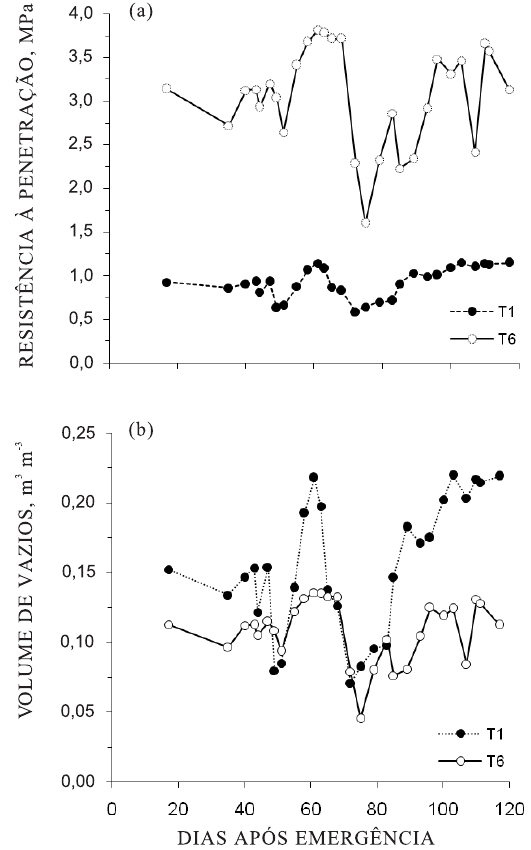
Figura 5. Variação da resistência do solo à penetração e volume de vazios na profundidade de 10–20 cm do Latossolo Vermelho durante o ciclo do milho para os tratamentos T1 (solo preparado e sem tráfego de máquinas) e T6 (solo preparado e submetido a oito passadas de um trator de 6